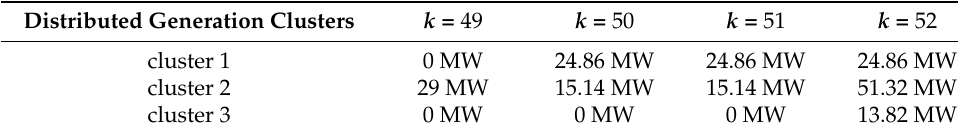
Table 3. Peak shaving tasks for distributed generation clusters.